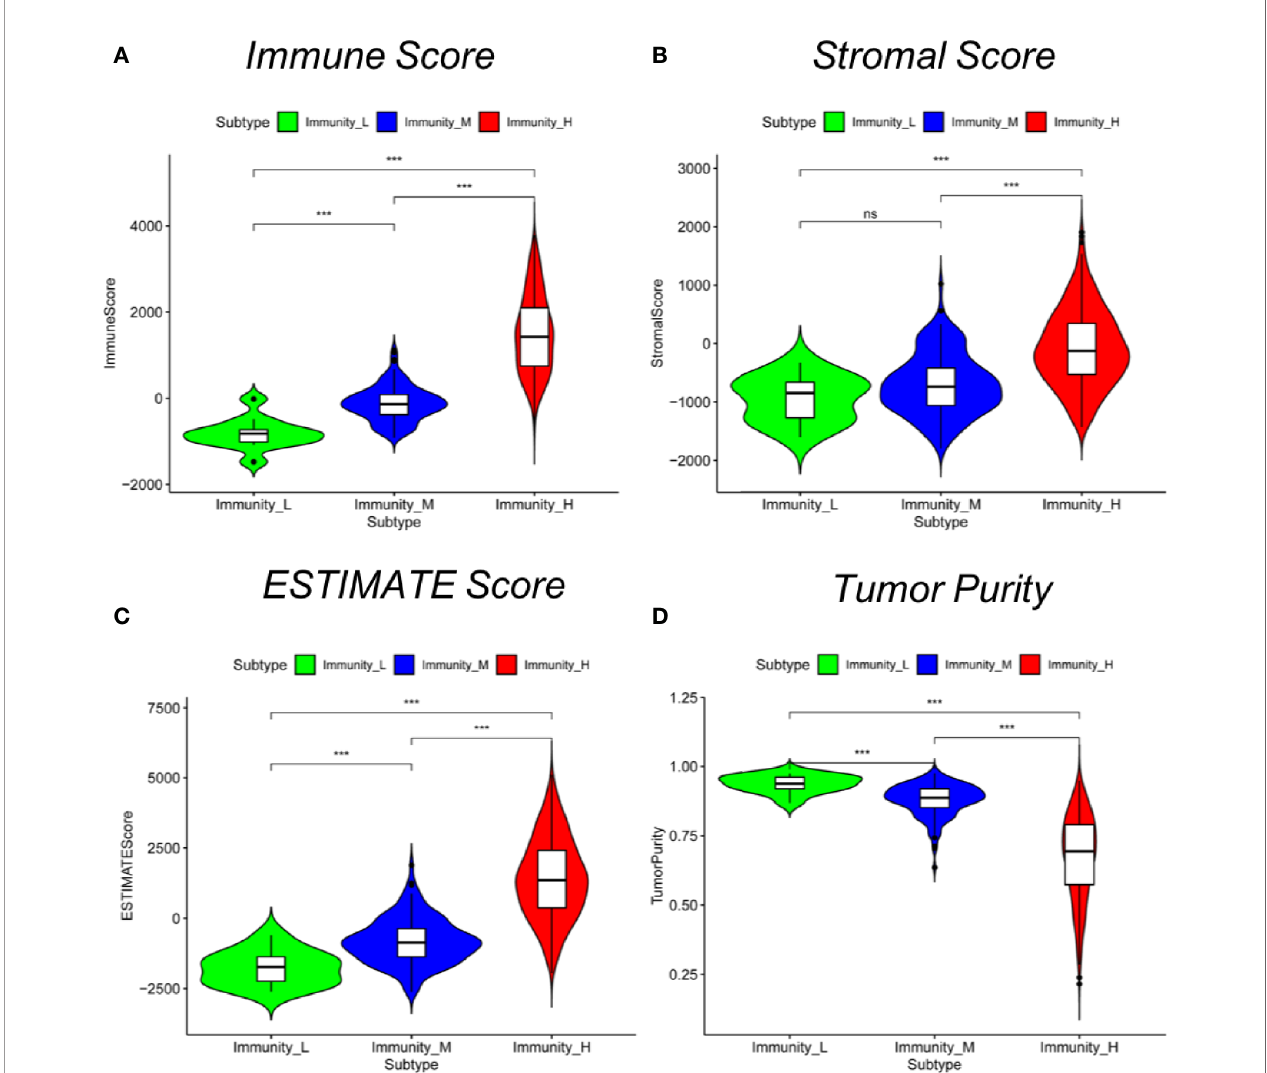
FIGURE 2 | Comparison of stromal scores, immune scores, estimated scores and tumor purity between cutaneous melanoma subtypes. Comparison of (A) stromal scores, (B) immune scores, (C) estimate scores, (D) and tumor purity between three subtypes (Mann – Whitney U test). * P < 0.05, *** P <